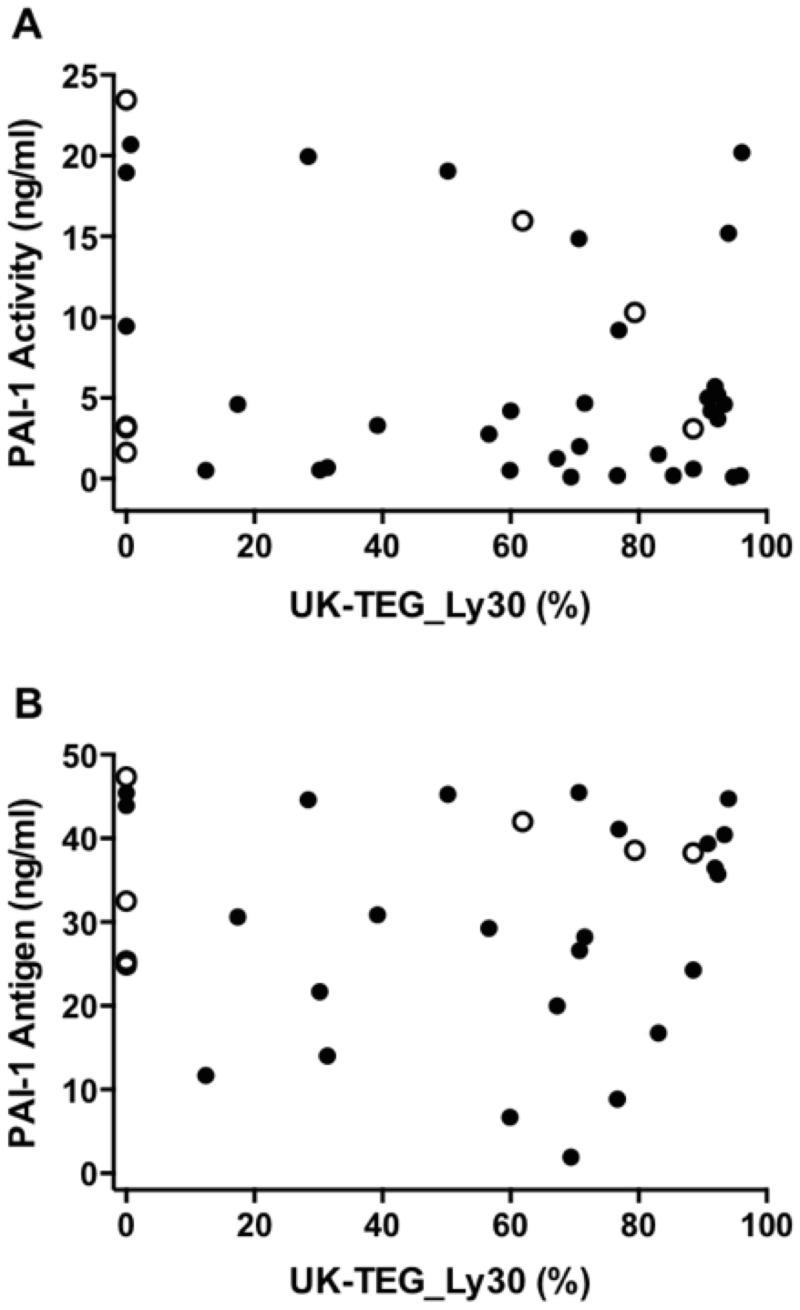
Correlation between different methods for assessing fibrinolysis in sepsis patients.Panel A: Correlation between PAI-1 Activity (ng/ml) and UK-TEG_Ly30 (%), Spearman's rho = -0.13, p = 0.44. Panel B: Correlation between PAI-1 Antigen (ng/ml) and UK-TEG_Ly30 (%), Spearman’s rho = -0.06, p = 0.72. Filled circles represent sepsis patients with SOFA score ≤ 10 (lower severity of disease), clear circles represent sepsis patients with SOFA score > 10 (higher severity of disease). PAI-1, Plasminogen Activator Inhibitor 1; UK-TEG_Ly30, Ly30 measured by UK-TEG.